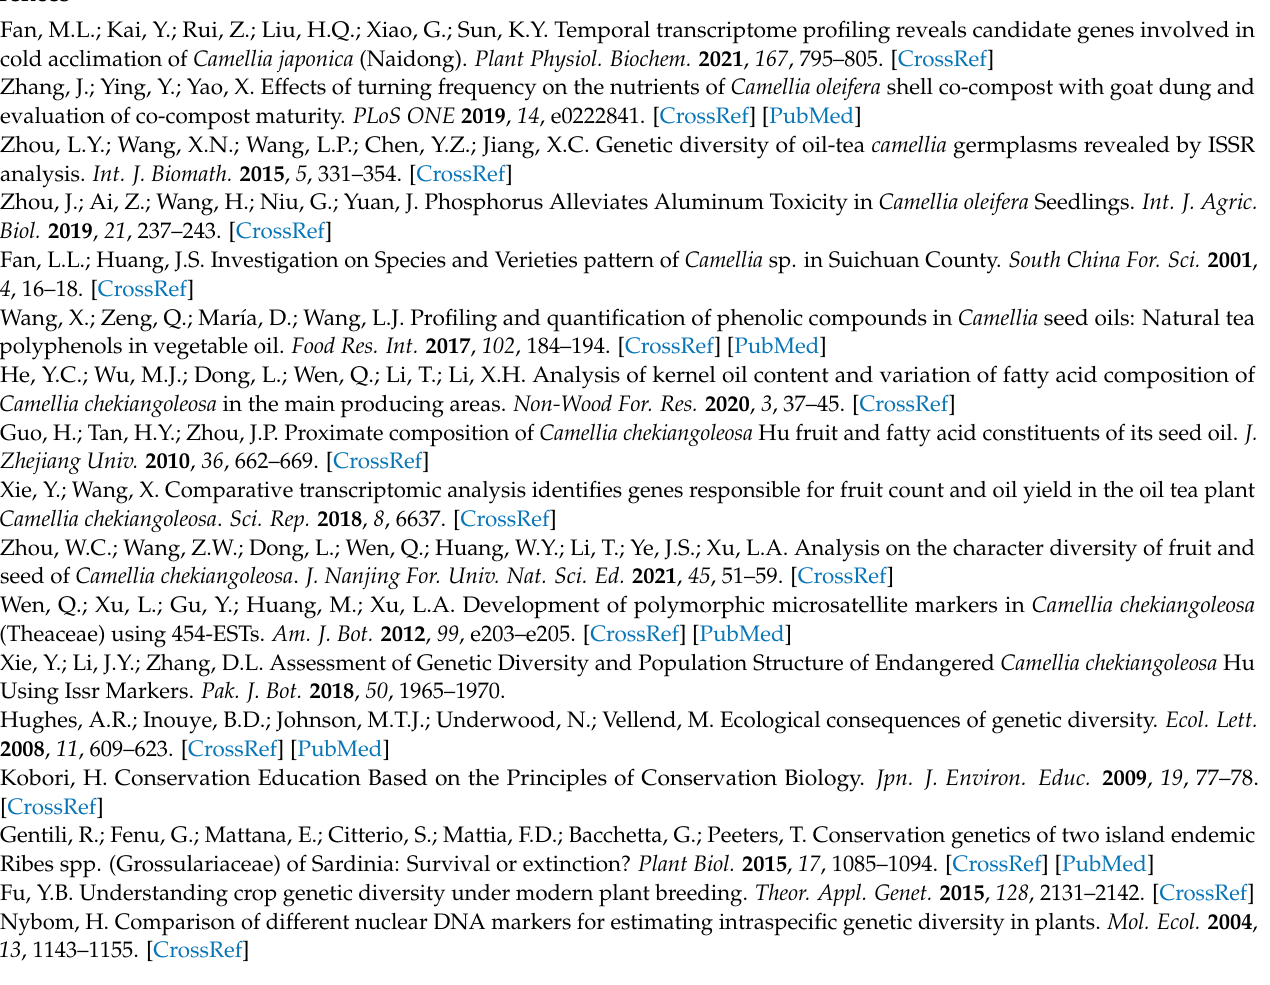
Figure S1: (a) The mean log-likelihood value of the data was based on ten repetitions for each K value, (b) The delta K value was changed with each K